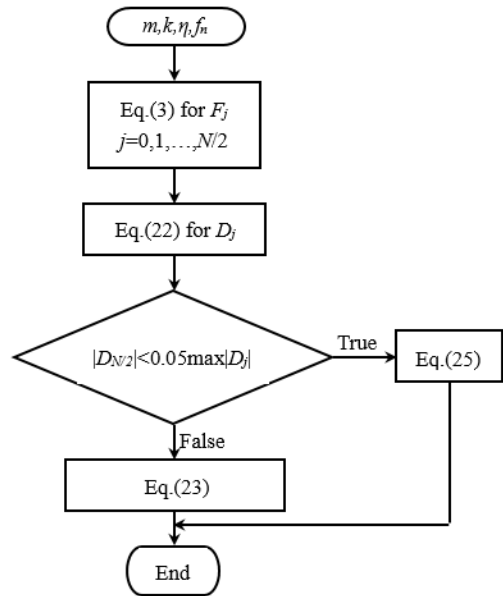
Figure 1. Flowchart of the developed fast frequency domain method.